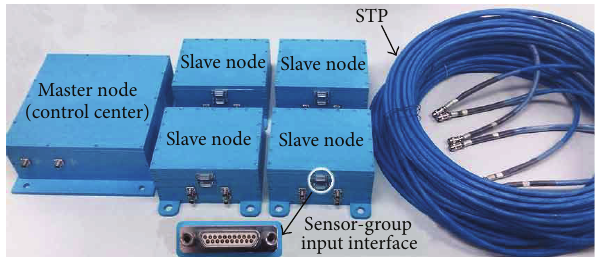
Figure 6: Experimental platform.